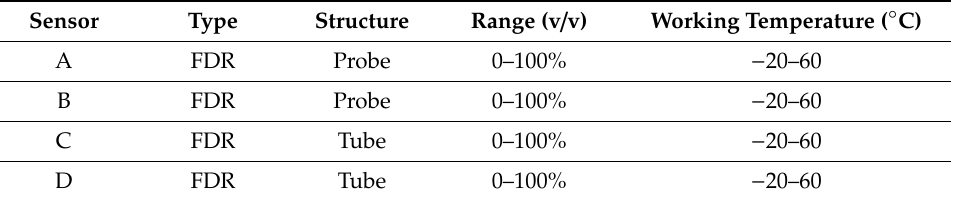
Table 1. Specifications of the